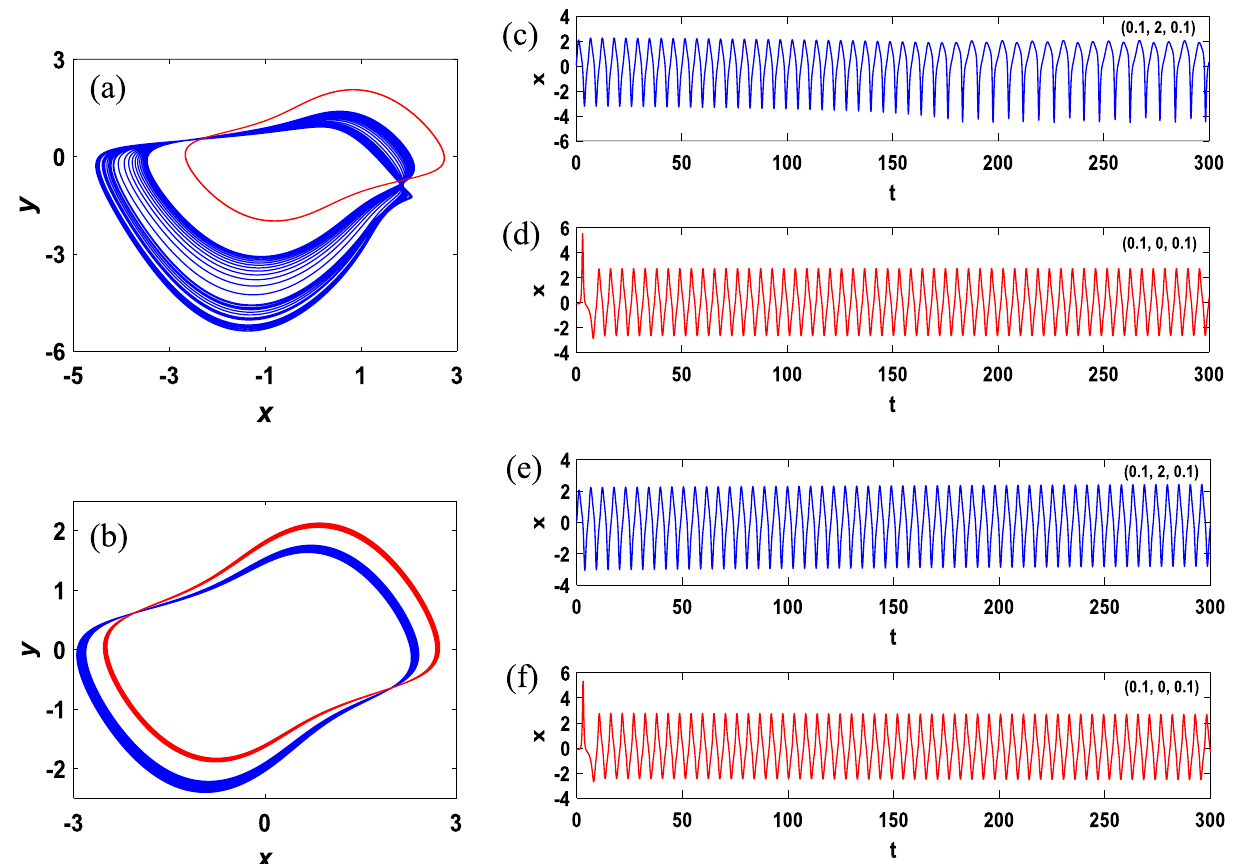
Figure 9. Two types of coexisting asymmetric attractors and time series of the variable x emerged from the initial values (0.1, 2, 0.1) and (0.1, 0,